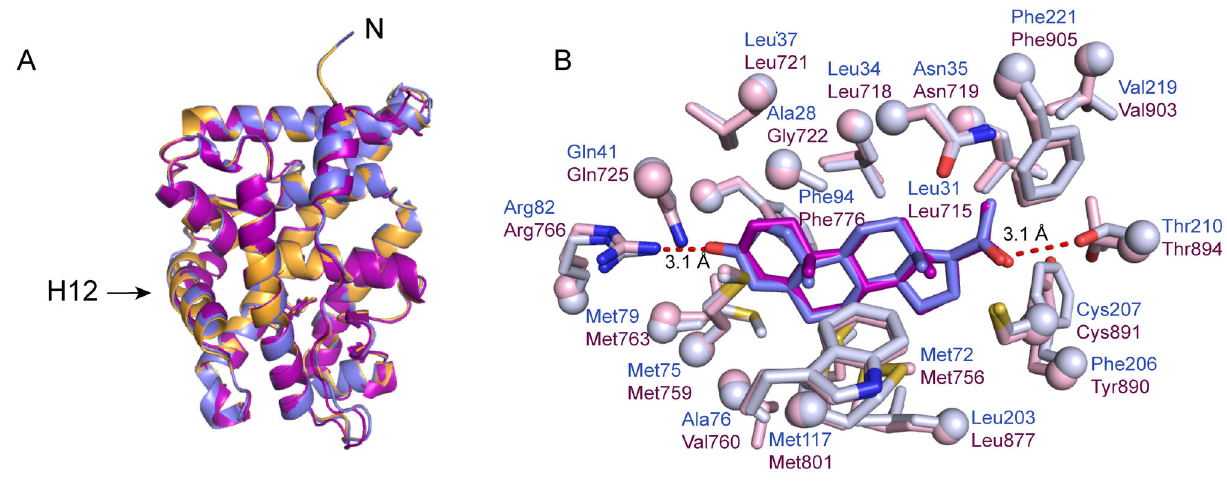
Figure 6. Global alignment of progesterone-bound steroid receptors. A cartoon representation of the ancSR2–progesterone– mifepristone (slate blue), ancSR2–progesterone (orange, PDB accession code: 4FN9), and progesterone receptor–progesterone (purple, PDB accession code 1A28) complexes overlay with high overall structural similarity. B. Ligand adopts an identical position and conformation in two progesterone-bound receptor structures . The ancSR2–progesterone–mifepristone (ligand – slate blue, receptor – light blue) and progesterone receptor–progesterone (ligand – magenta, receptor – light pink, PDB accession code 1A28) structures show identical positioning and conformation of the ligand within the ligand binding pocket. Progesterone makes hydrogen bonds with Arg82 and Thr210 in both structures (dashed red lines). doi: